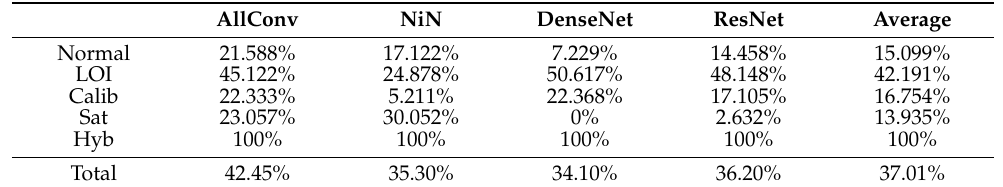
Table 5. The probability of being mistaken under target attack (3 pixel). AllConv: all convolution network. NiN: Network in Network. Normal: the unattacked state. LOI: LO intensity attacks. Calib: calibration attacks. Sat: saturation attacks. Hyb: the hybrids attacks. AllConv NiN DenseNet ResNet Average Normal